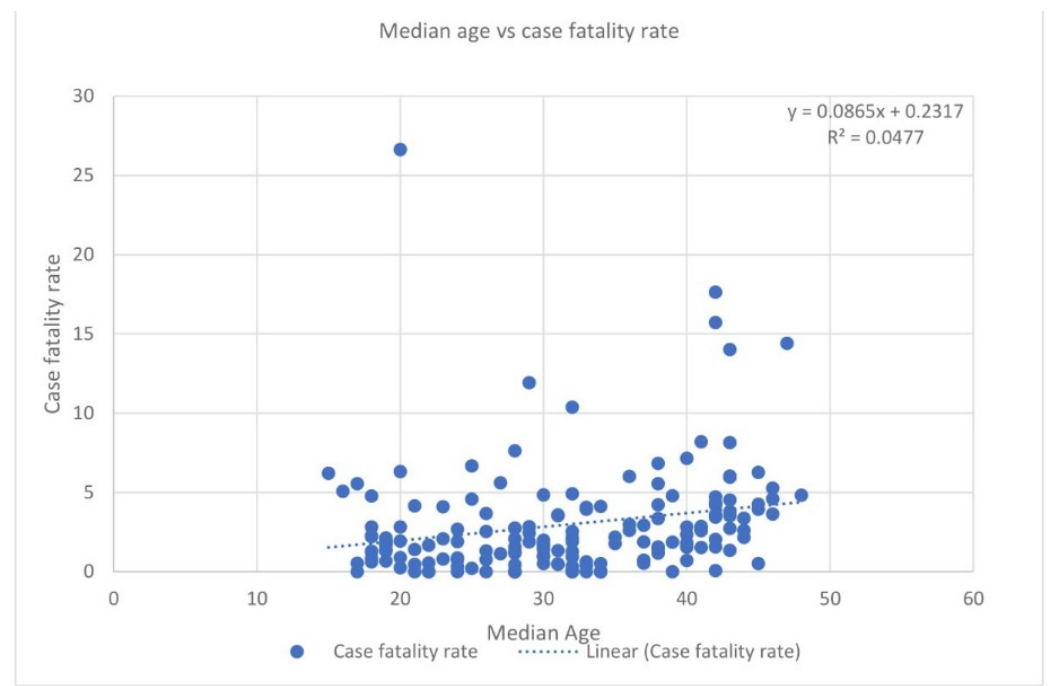
Figure 1. Correlation between median age and case fatality rate.